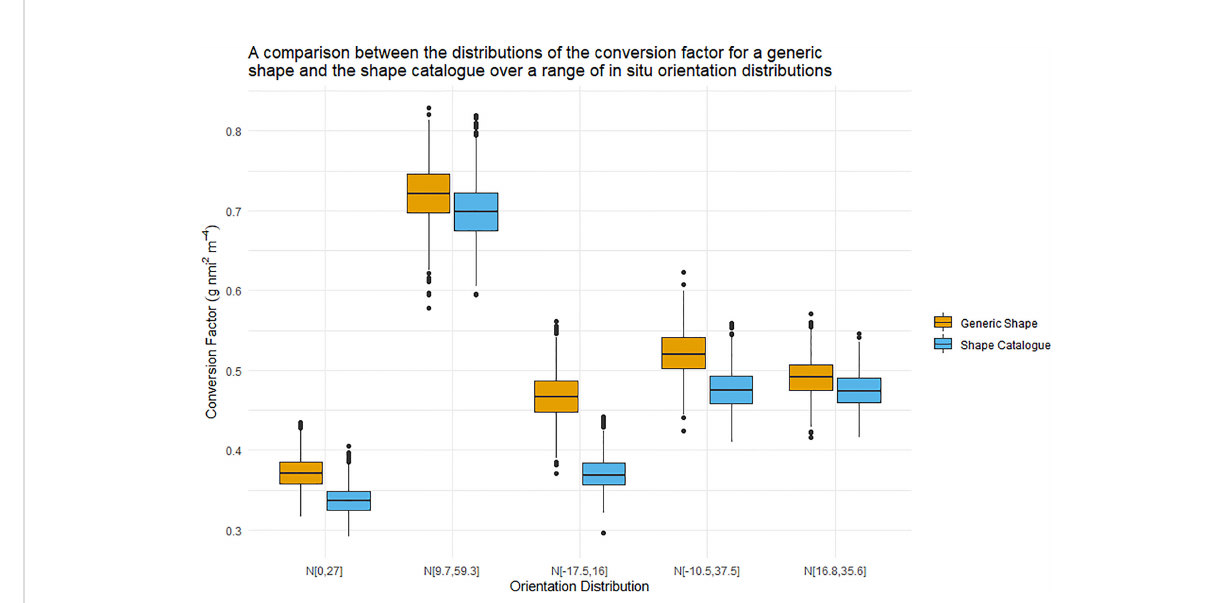
FIGURE 6 Boxplots illustrating the distribution of the conversion factor for both the generic shape (orange) and the shape catalogue (blue). The fi ve orientation distributions considered here were measured in situ . The central line of each boxplots indicated the median conversion factor value. The boxplot whiskers illustrate the 95th percentile and values outwith this range are indicated by data points.